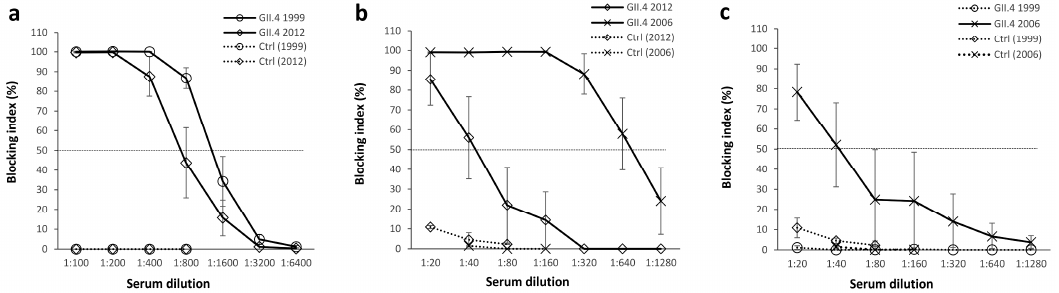
Figure 2. Norovirus (NoV) type-specific and cross-reactive blocking antibodies. GII.4 1999 (5 mice) or GII.4 2012 (4 mice) virus-like particle (VLP) immunized mice sera were individually diluted 2-fold starting from 1:100 dilution and assayed for the blocking of homologous NoV VLPs binding to human type A saliva ( a ). The cross-blocking activity of GII.4 1999 ( b ) and GII.4 2012 ( c ) VLP immunized mice sera as well as control mice (Ctrl, 5 mice) was assayed against heterologous VLPs as 2-fold dilution series starting from 1:20 dilution. The blocking index (percent) was calculated as follows: 100% × ((OD wells with serum/OD wells without serum, maximum binding) × 100%). The symbols represent the immunization group mean blocking indexes and the error bars represent the standard error between individual mice. The horizontal dashed line represents the blocking titer 50%